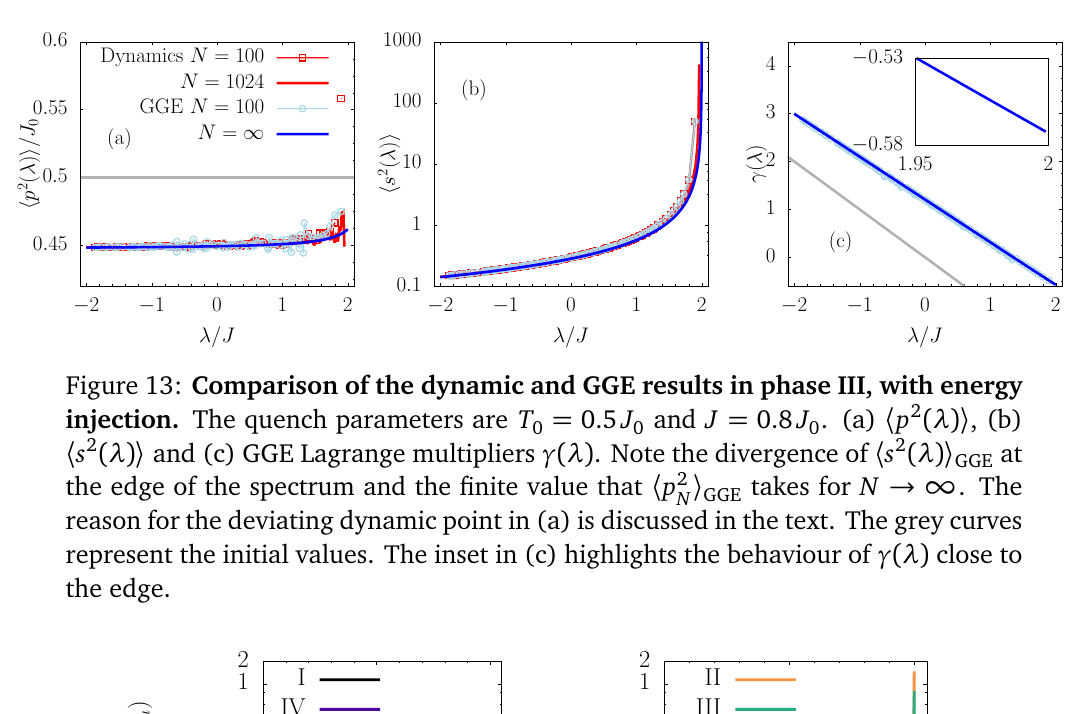
= 0.5 J and J = 0.8 J . (a) 〈 p 2 ( λ ) 〉 , (b) 0 0 0 at GGE 〉 takes for N → ∞ . The GGE N